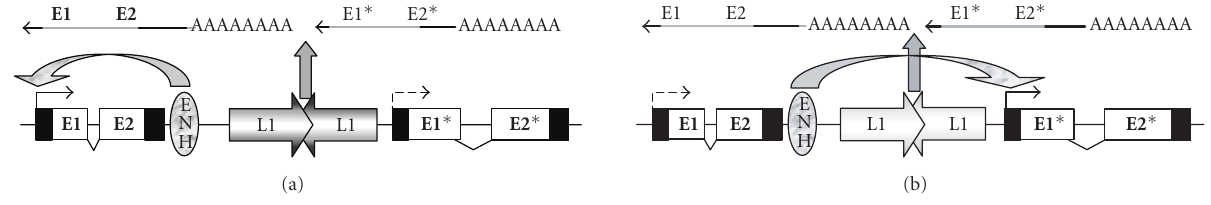
Figure 2: Postulated boundary e ff ect of intergenic L1 clusters. Being strongly methylated and tightly packed into chromatin, clustered L1 sequences might act as boundaries between genes, restricting the interaction of an enhancer (ENH) to one gene (a). In cancer cells, L1 hypomethylation could destroy this function and cause deregulation by allowing enhancer interaction with a neighboring gene